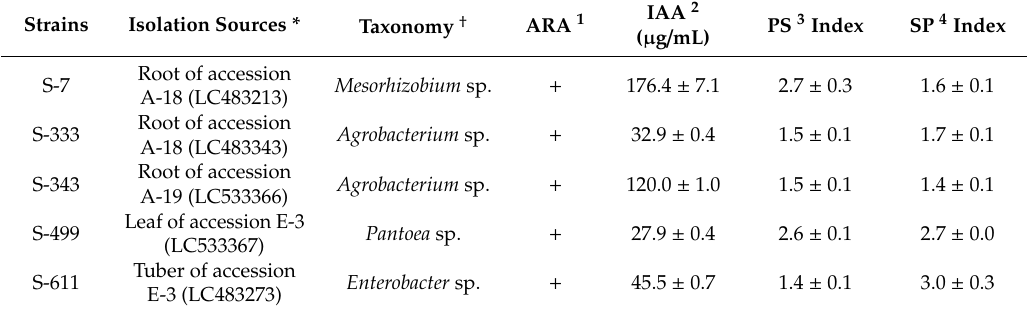
Table 1. The plant growth-promoting traits of the bacterial strains used in this study. † Bacteria were identified based on their partial 16S rRNA gene sequences. The supplementary file S1 describes the protocol used to taxonomically classify the strains used in this study. * Values in parenthesis are the accession numbers of the 16S rRNA gene sequences deposited in the DDJB database. S-7, S-33 and S-343 were isolated from the water yam ( Dioscorea alata L.) while S-499 and S-611 were isolated from the lesser yam ( Dioscorea esculenta L.). 1 Acetylene Reduction Assay, 2 Indole 3-Acetic Acid, 3 Phosphate solubilization, 4 Siderophores